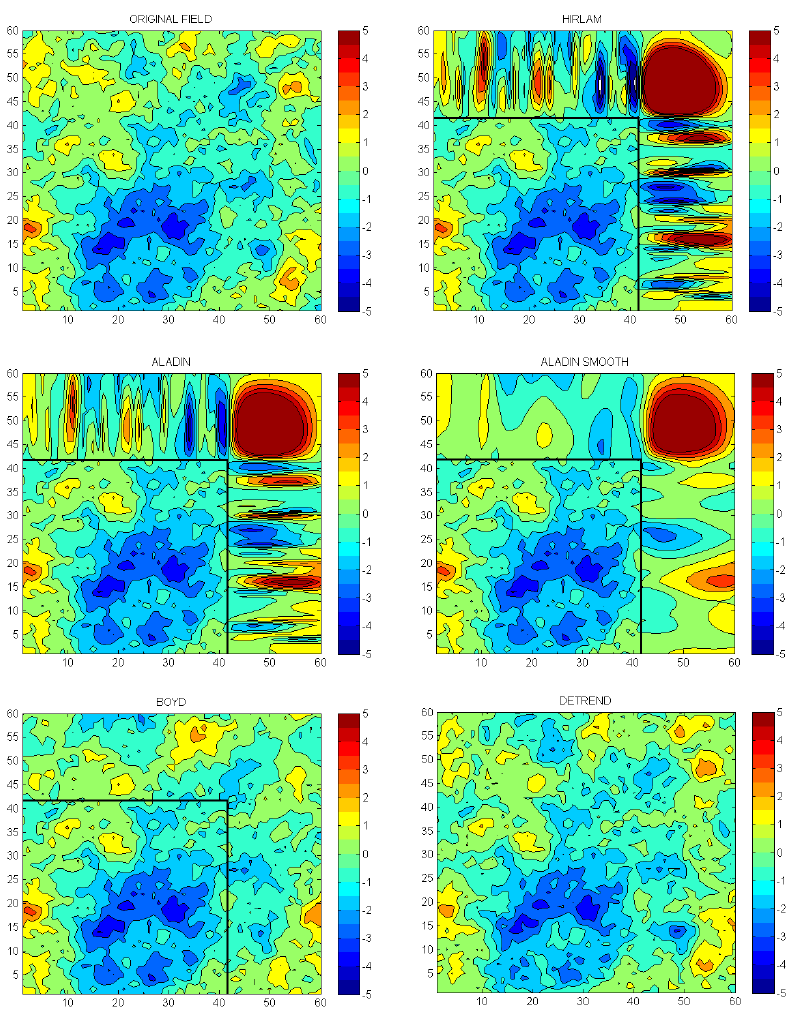
Figure 4. The arbitrary 2-D wind fields before (top left) and after the periodization for the HIRLAM, ALADIN, ALADIN SMOOTH, Boyd and detrending methods. The black lines denote the borders of the extension zone.